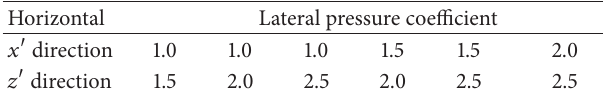
Table 4: Lateral pressure coefficient